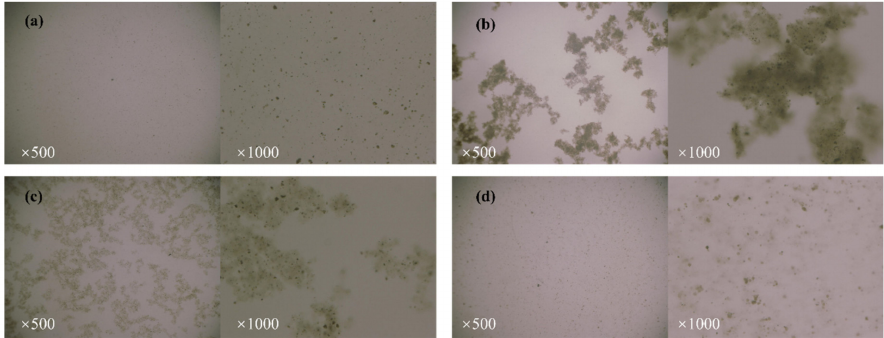
Figure 11. Ultra-depth field microscopic image of GO in different systems: ( a ) GO-W; ( b ) GO-CHS; ( c ) GO-CAS; and ( d ) GO-NHS.